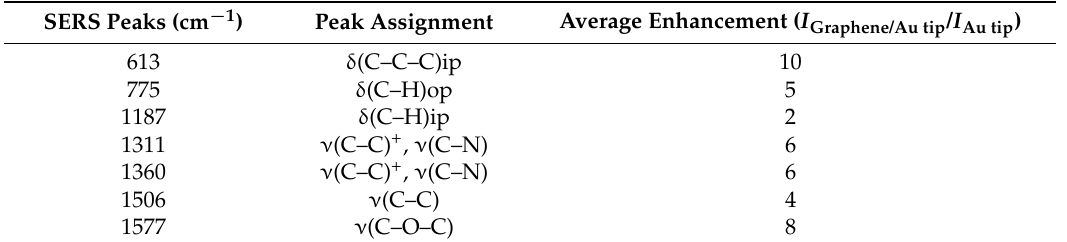
Table 2. Vibration mode dependent enhancement and assignment of Raman peaks in SERS spectra for R6G